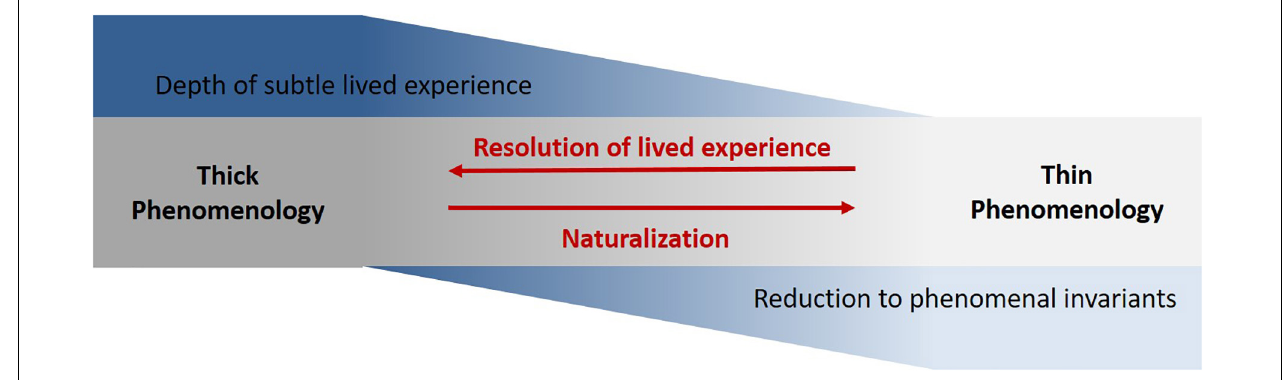
FIGURE 1 | Tension and trade-off between phenomenological thickness and naturalization. The thick and thin phenomenology extremes form a continuum of the depth of 1P data